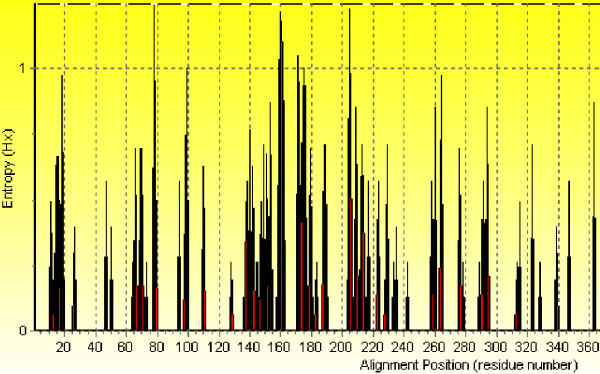
Entropy plot of the protein consensus ClustalW alignment. Amino acid positions that do not exhibit any changes over the years have entropy of 0, whereas positions of high variability are represented by peak in the plot. Two hot spots of variability were observed and are clustered around amino acid position 140–190, and 200–240. The entropy analysis was performed for the entire hemagglutinin sequence (560 amino acids), but at amino acid position 340 (HA2) the analysis does not exhibit much entropy.